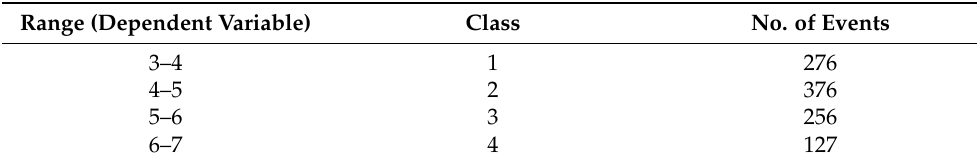
Table 2. The boundaries of output classes.